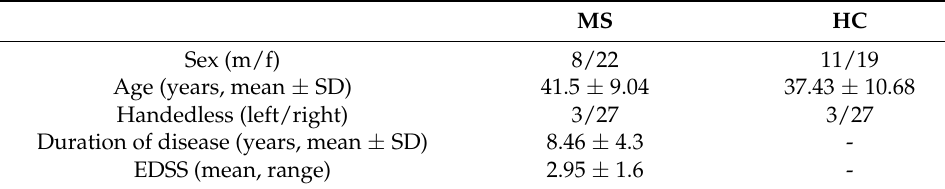
Table 1. Sociodemographic data.